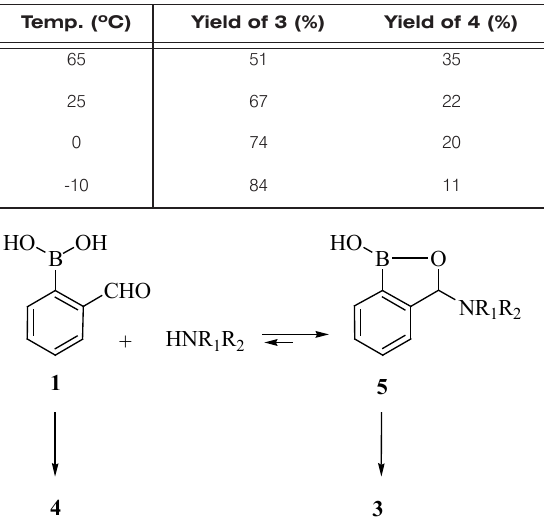
Table 1. Isolated yields of 3 a nd 4 depending on temperature of the reaction. Temp. (ºC) Yield of 3